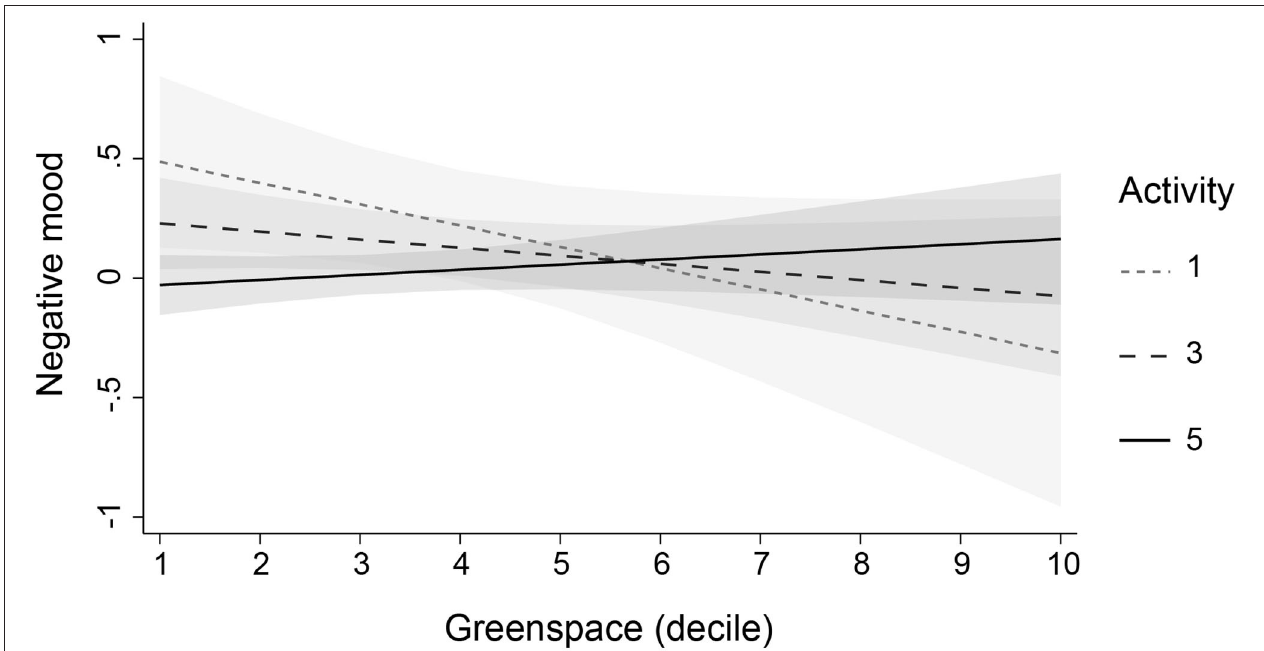
FIGURE 3 | Moderation of the effect of greenspace on negative mood by physical activity. This plot illustrates the moderating role of physical activity in the association of greenspace with negative mood (linear predictions). Plots are based on non-imputed data. Shaded areas are 95% confidence intervals. Physical activity levels ranged from 1 “never” to 5 “most days.” Please note that, for visual clarity, first, the y-axis does not cover the whole scale of negative mood, and second, lines for activity levels 2 and 4 were